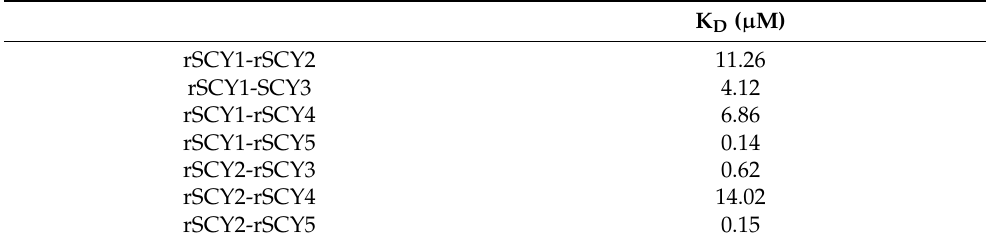
Table 2. Binding kinetics of rSCY1 and rSCY2, rSCY1 and rSCY3, rSCY1 and rSCY4, rSCY1 and rSCY5, rSCY2 and rSCY3, rSCY2 and rSCY4, and rSCY2 and